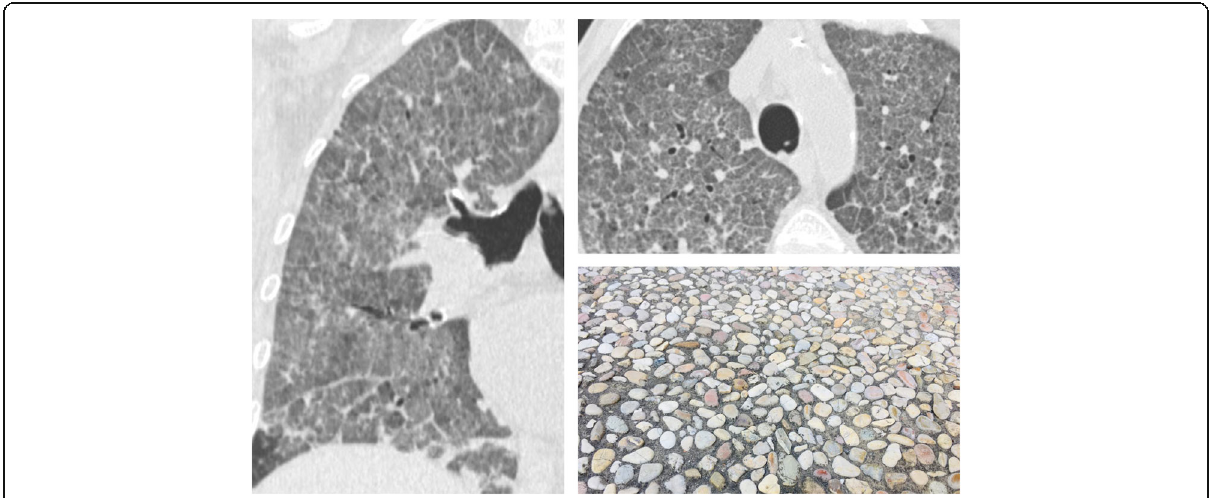
Fig. 6 Crazy paving. Coronal (left side) and axial (right side) CT images show ground glass attenuation of the lungs — with superimposed reticulations, in a patient with Pneumocystis jirovecii infection. This appearance looks like the “ roman crazy paving ” and may be associated also